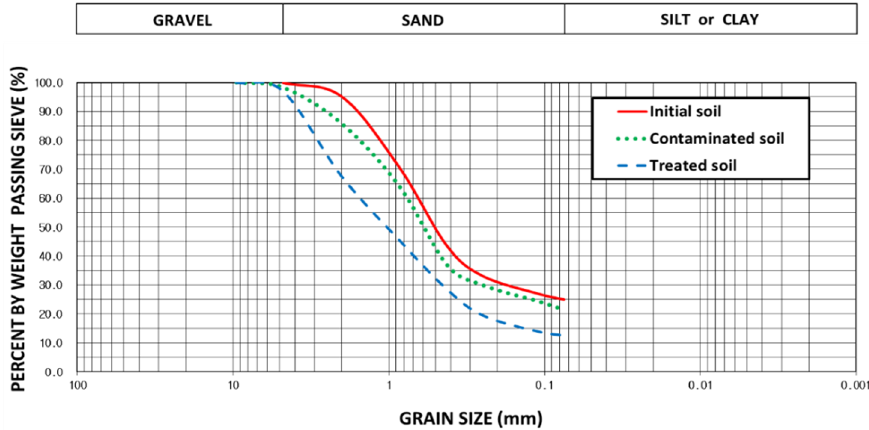
Figure 1. Particle size distribution curves of initial, lubricant-contaminated and treated soil (Based on ASTM D-6913) [28]. Table 1. Physical properties of initial, lubricant-contaminated and treated soil.